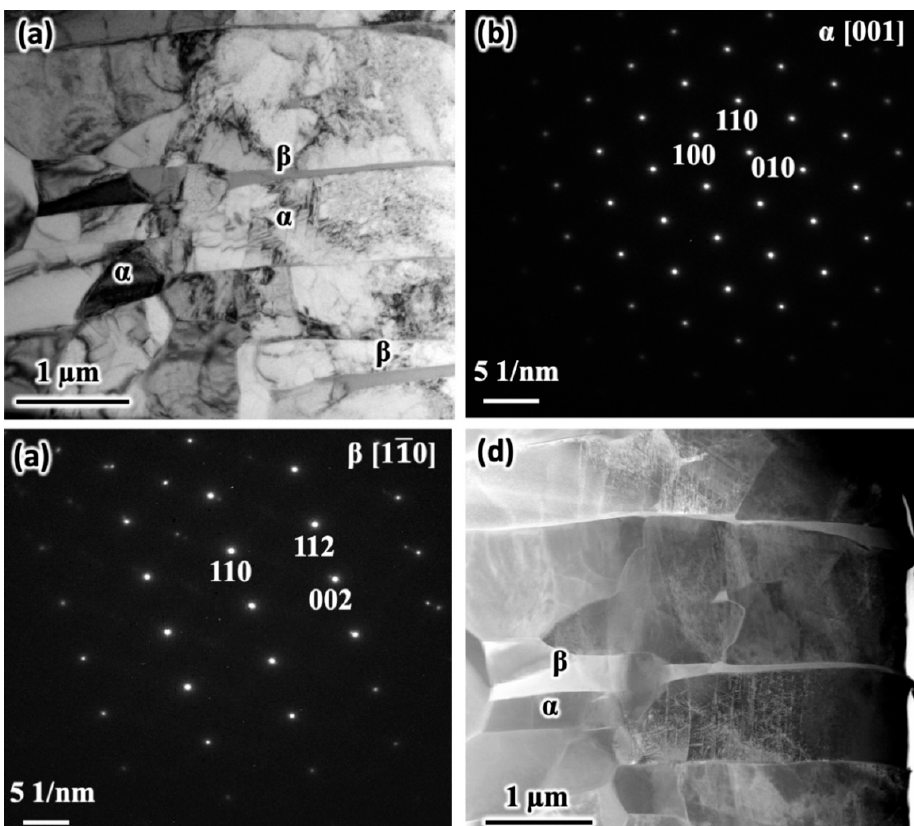
Figure 9. TEM observations from the representative HIP sample: ( a ) bright field micrograph, ( b ) SAED pattern from the α phase, ( c ) SAED from the β phase, and ( d ) HAADF STEM micrograph.